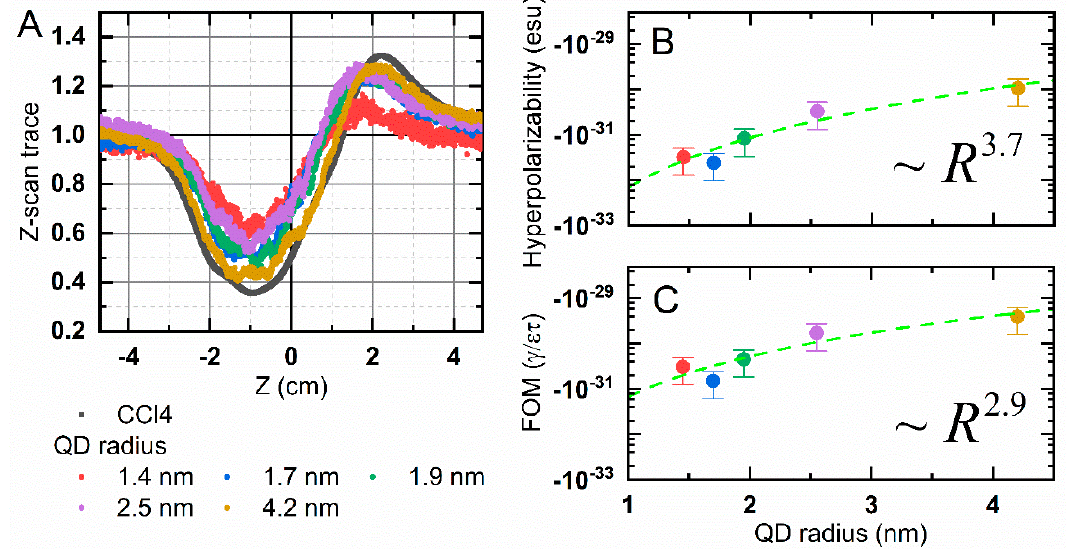
Figure 5. A —Z-scan traces for QD solutions with different sizes (black squares—pure CCl 4 ); B —QD second-order hyperpolarizability vs. QD size; ( C )—nonlinearity figure of merit (FOM) of PbS QDs vs. second-order hyperpolarizability vs. QD size; C —nonlinearity figure of merit (FOM) of PbS QDs vs. QD QD size.